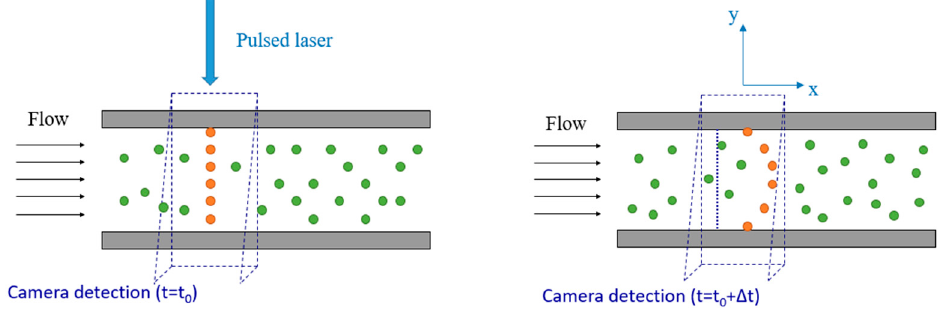
Figure 1. Basic principle of 1D-molecular tagging velocimetry (MTV) by direct phosphorescence, for a gas flowing in a plane channel from left to right.